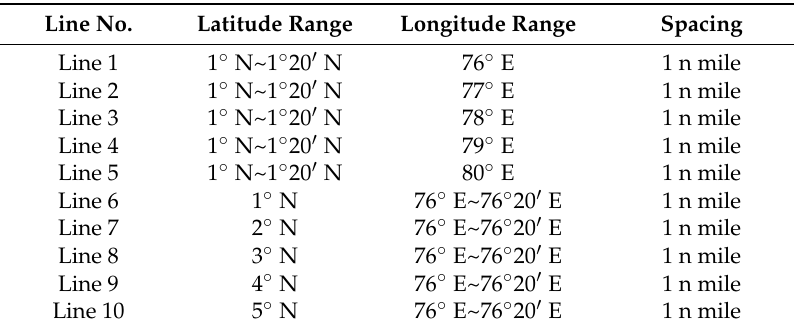
Table 4. The coordinate range of the short survey lines.